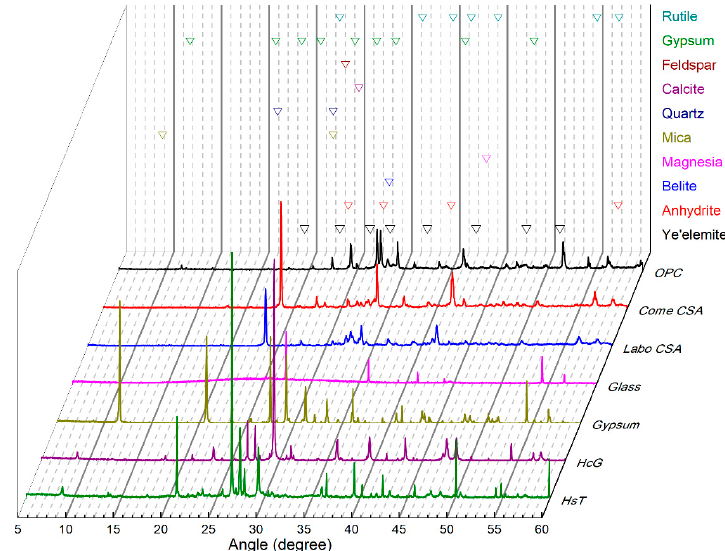
Figure 1. XRD analysis of raw materials.